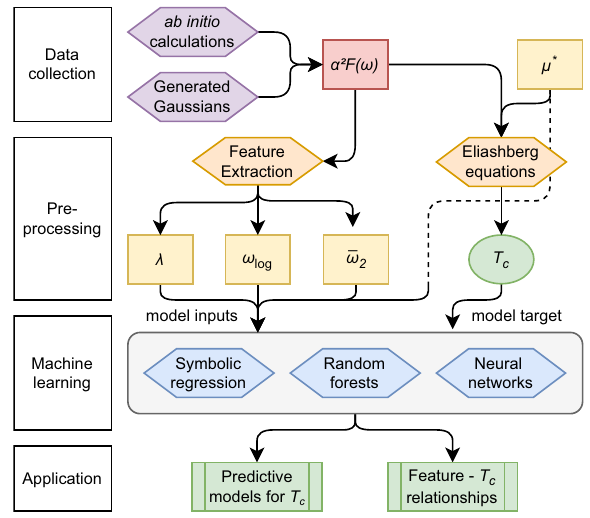
Fig. 1 Work fl ow for identifying new machine learning models for α 2 F ( ω ) spectra and derived quantities. The work fl ow is T c from organized into four computational modules: data collection, preprocessing, machine learning, and application.